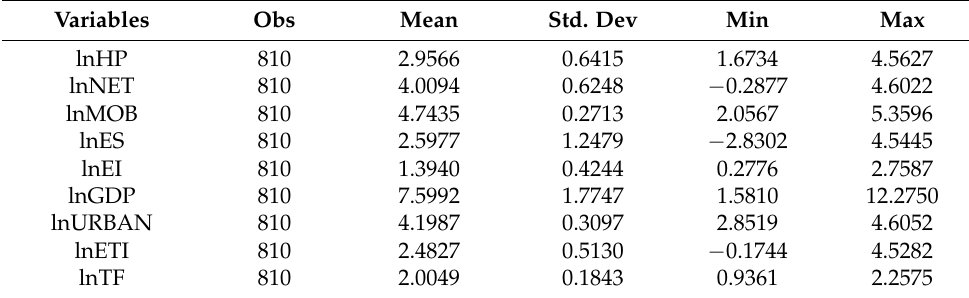
Table 2. Descriptive statistics of